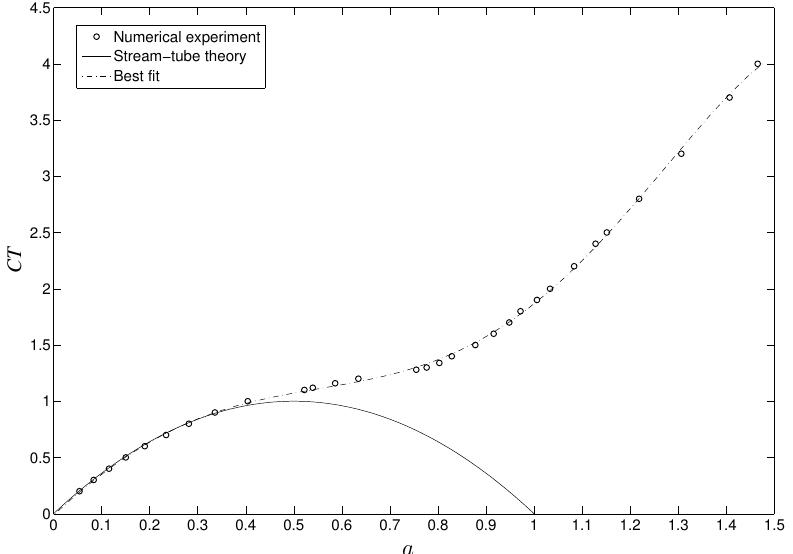
Figure 9. Thrust coefficient CT versus axial induction factor a obtained from the numerical experiments, a best-fit curve to the data obtained by a least-squares regression of a 4th order polynomial, and the parabolic relation given by the classic streamtube momentum